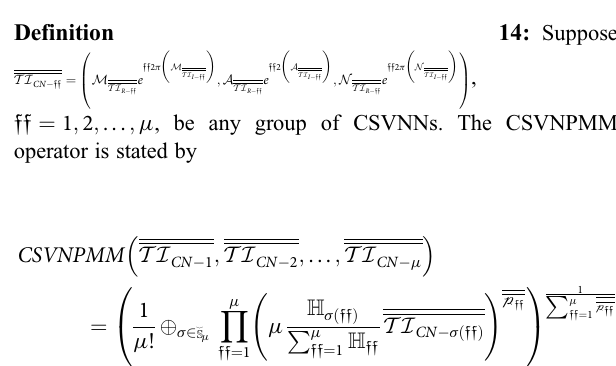
CSVNPMM operator and CSVNPDMM operator is elaborated and their particular cases are discussed. The technique of PMM aggregation operator is massive, dominant, and more flexible